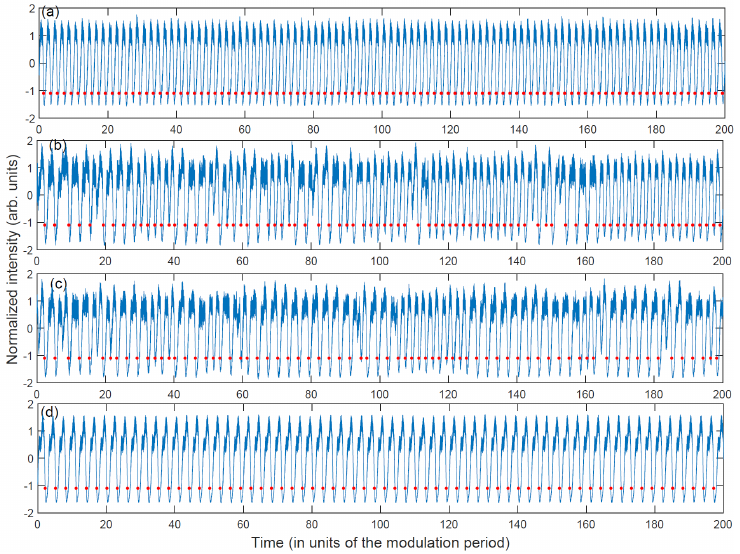
Figure 5. Transition between 2:1 and 3:1 regular locking, when the modulation frequency in- creases while the modulation amplitude is kept constant. The parameters are a mod = 0.0125 and f mod = 35 MHz ( a ), 37 MHz ( b ), 39 MHz ( c ), 40 MHz ( d